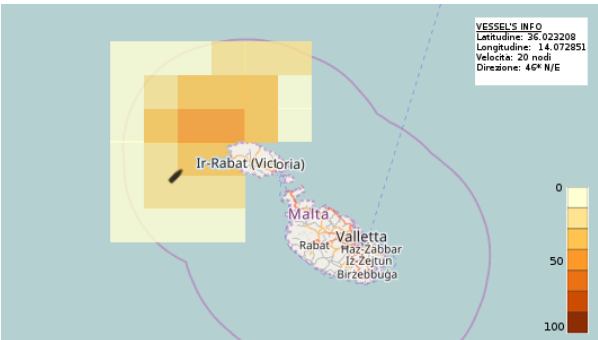
Figure 11. The probability